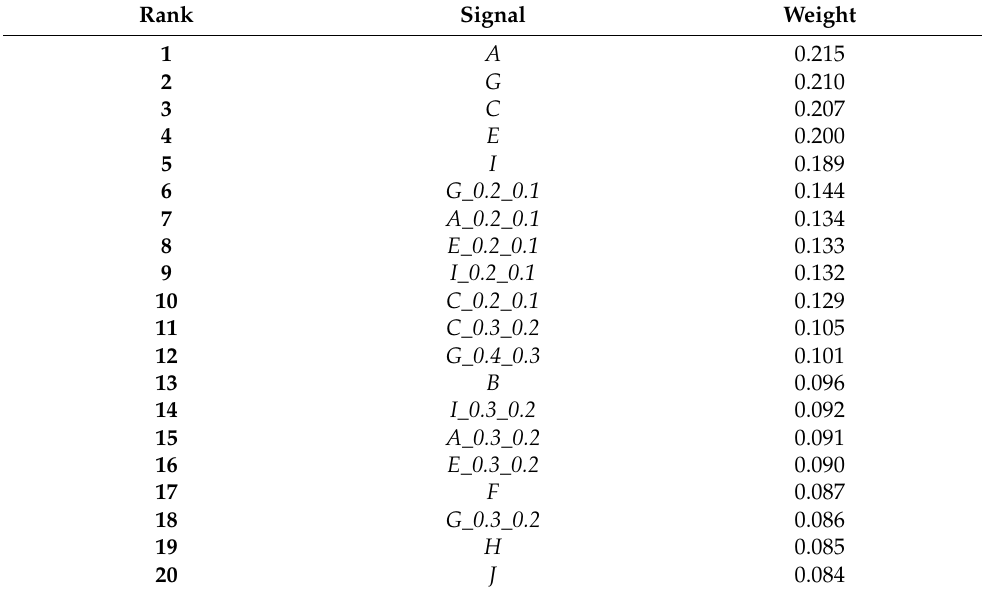
Table 3. Twenty top-ranked features of the modified “poker8vs6”